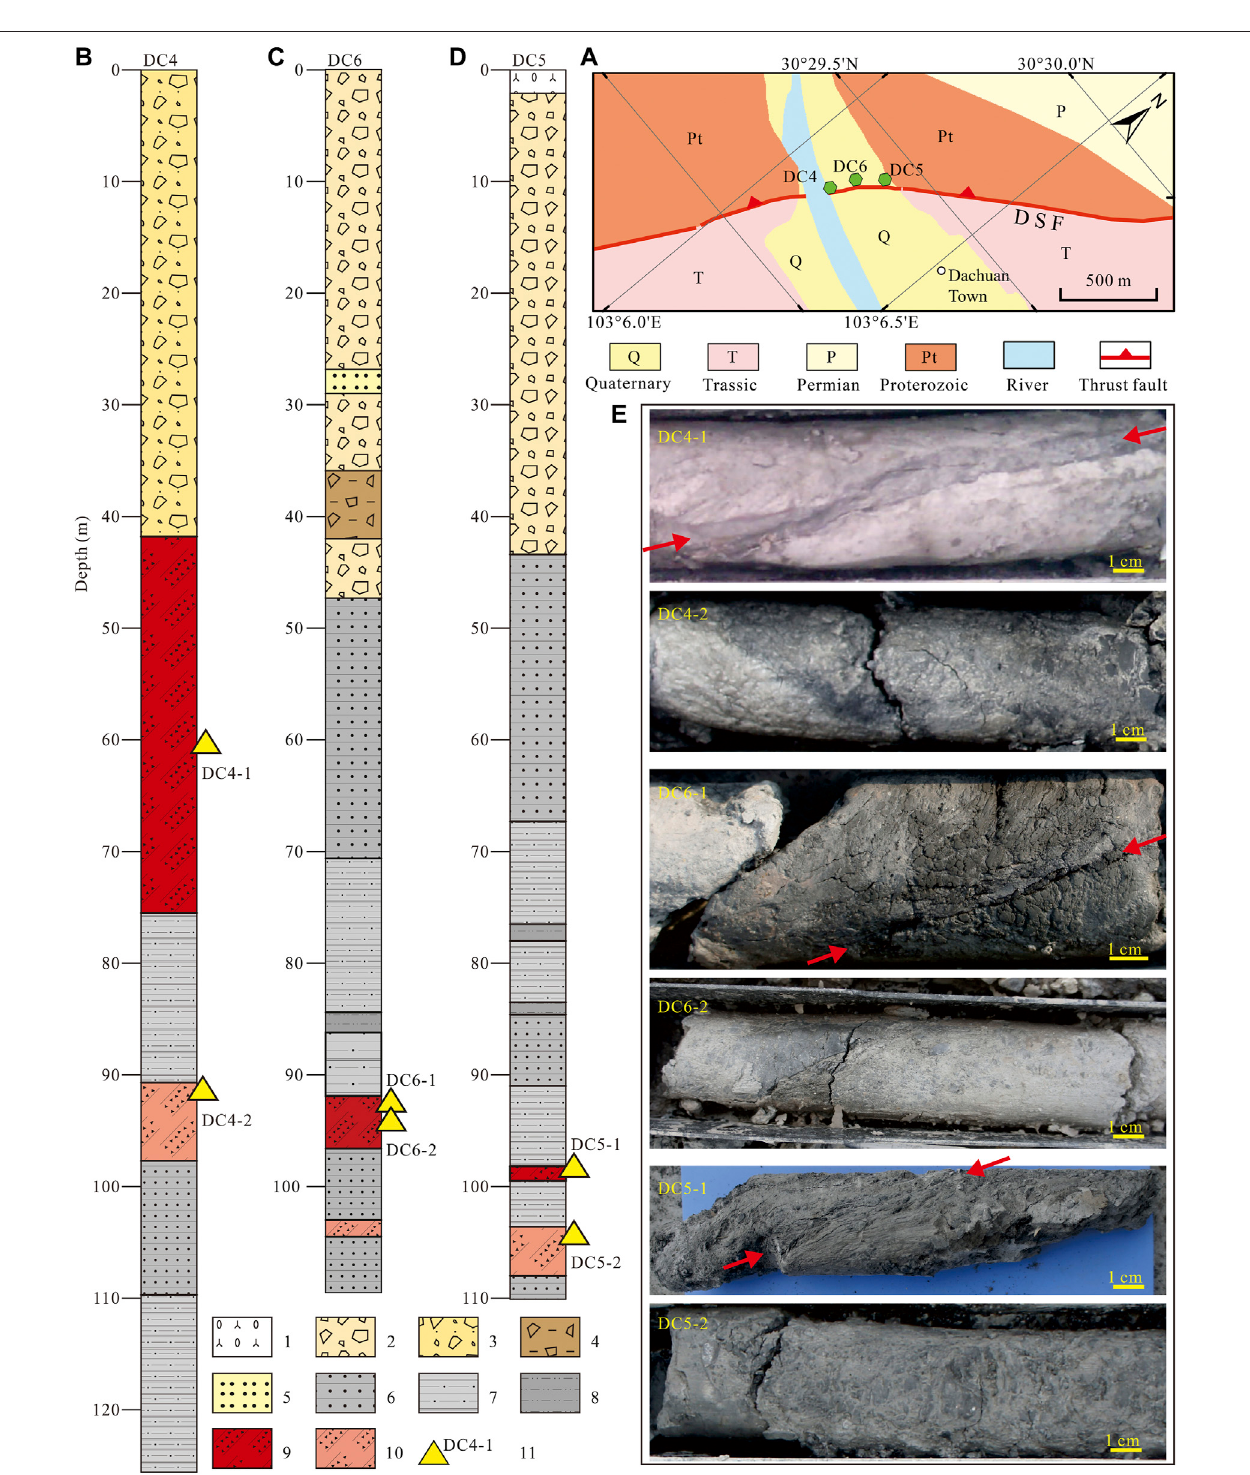
FIGURE 3 | (A) Geological map showing the borehole positions (green dots) at the Dachuan site (DC in Figure 1B and Figure 2 ) relative to the DSF. (B – D) Core logs of boreholes DC4, DC6, and DC5. Legends: 1: arti fi cial soil fi ll, 2: boulder, 3: gravel intercalated with clay, 4: sandy gravel, 5: sand bed, 6: sandstone, 7: fi ne sandstone,8:siltysandstone,9:activefaultbelt,10:oldfaultfracturebelt,and11:samplingsiteandnumber. (E) Photographsofcoresampleswithredarrowsshowing locations of localized, soft, and thin fault gouge in fractured zones.